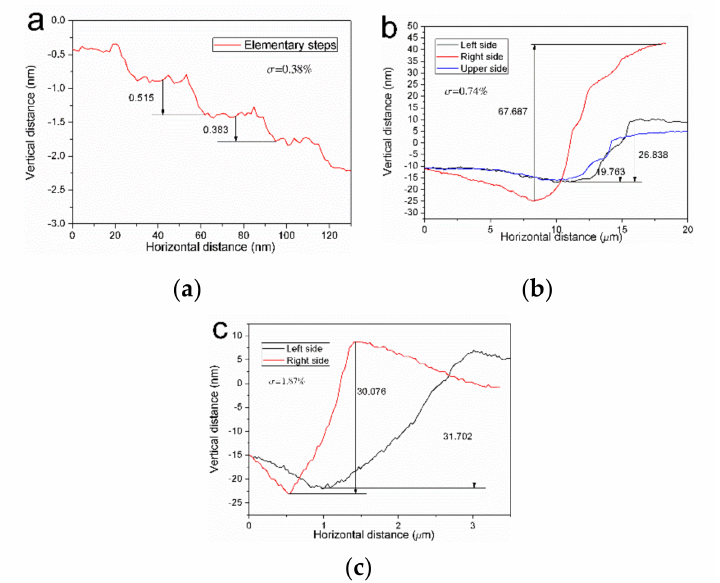
Figure 4. Steps profile images measured by AFM under di ff erent supersaturation: ( a ) σ = 0.38%; ( b ) σ = 0.74%; ( c ) σ =